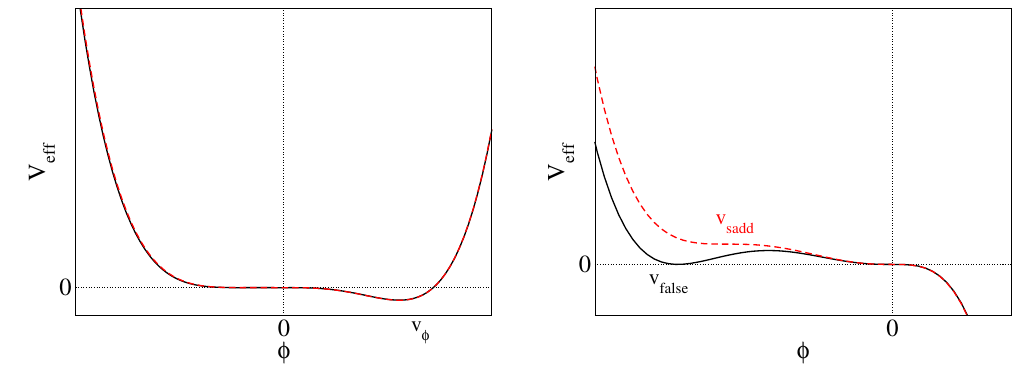
symmetry at the CP 2-1 (solid curve) and 2